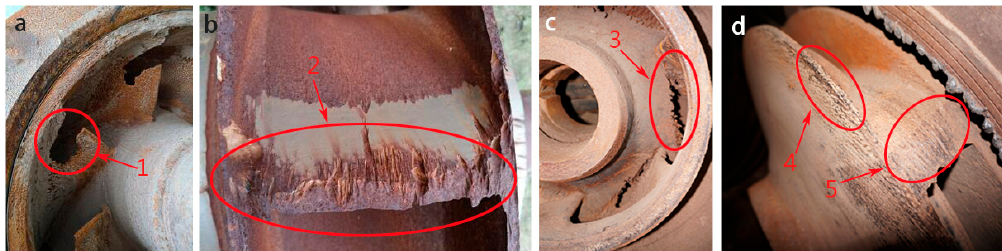
Figure 1. Silt erosion of impellers in double-suction centrifugal pumps in the Yellow River pumping stations: ( a , b ) damage to (1) blade inlet and (2) blade outlet in runner at Jiamakou pump station after 2000 h of operation. ( c , d ) Damage to (3) hub, (4) shroud and (5) blade outlet in runner at Huilong pump station.